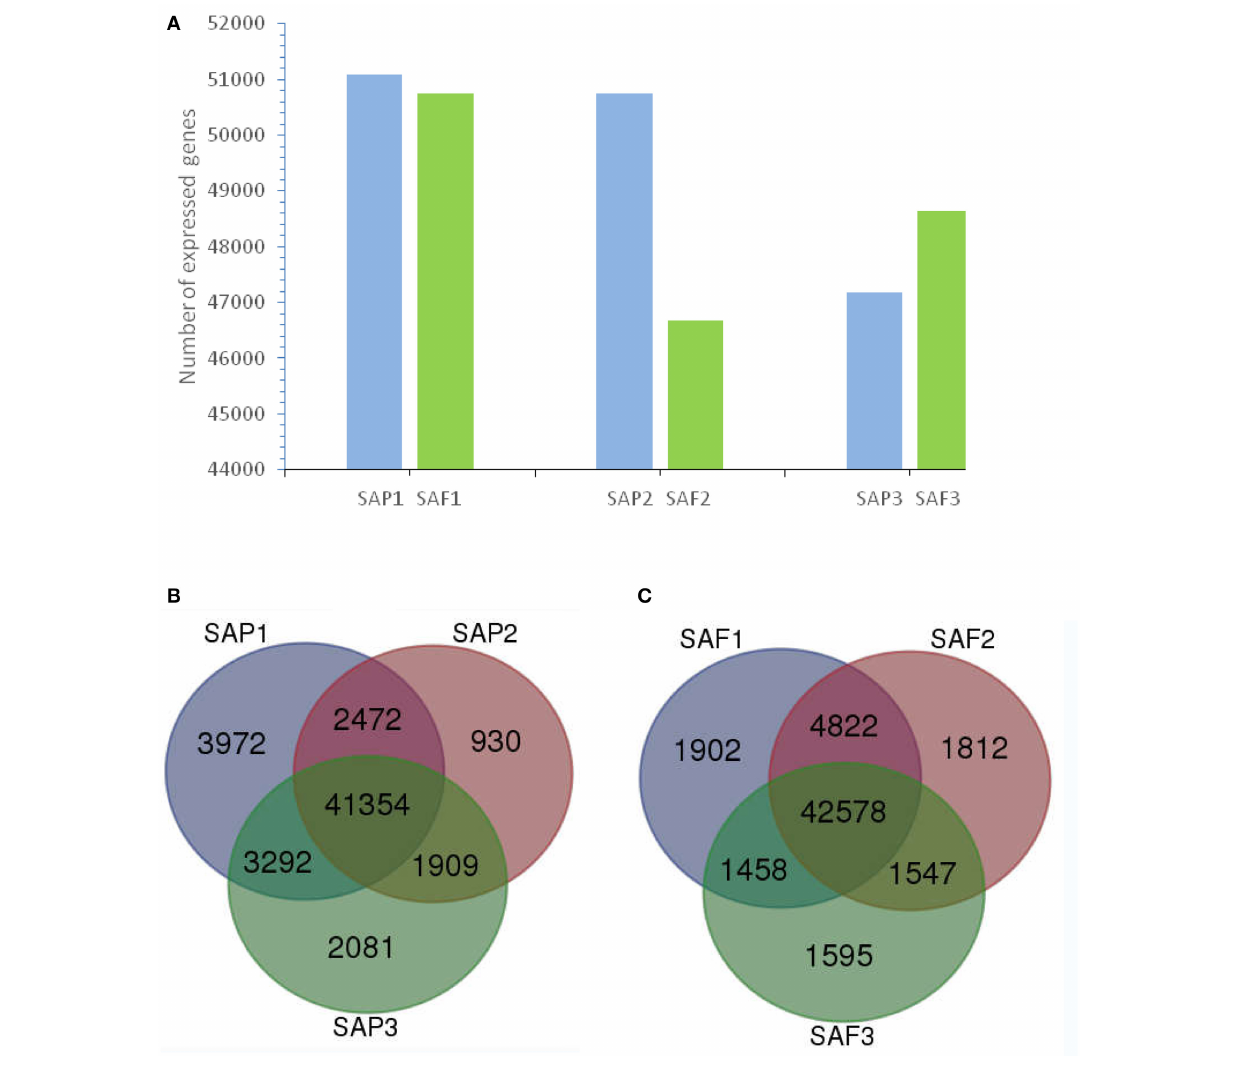
FIGURE 3 | Transcriptome analysis of stem apex of primocanes and floricanes in Rubus . (A) Transcriptome sizes of stem apex of primocanes and floricanes at three developmental stages. (B,C) Venn diagram showing the overlaps between three stages of SAP and SAF. The number in parentheses after each stage designation is the total transcripts detected in that